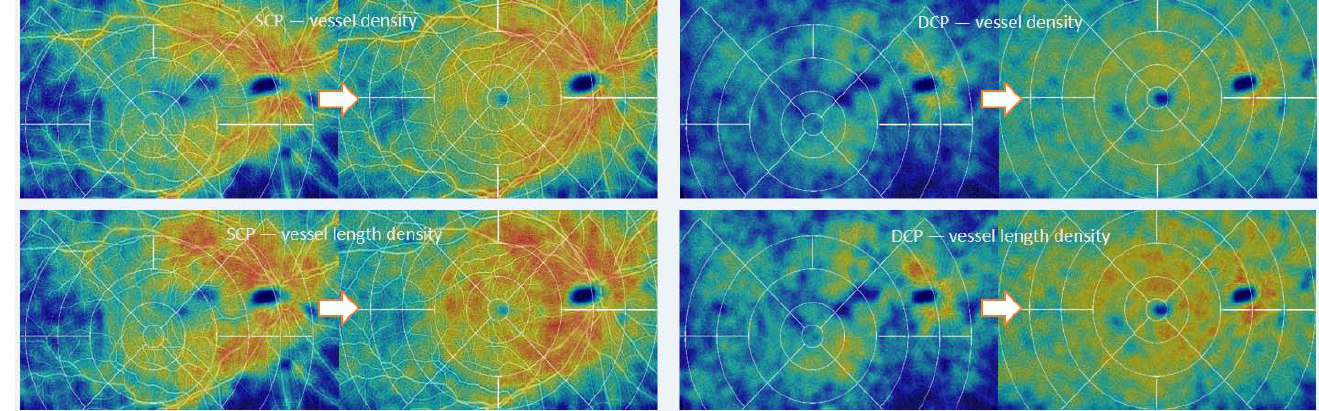
Figure 4. Heatmaps of 9 × 15 mm scans. Exemplary case where flow generally appears to be improved after TAVI. These images are gained by applying a data visualization technique using color hues to indicate flow intensities on standard OCTA scans. This algorithm is still under further development. The images do not represent relative blood flow speed.